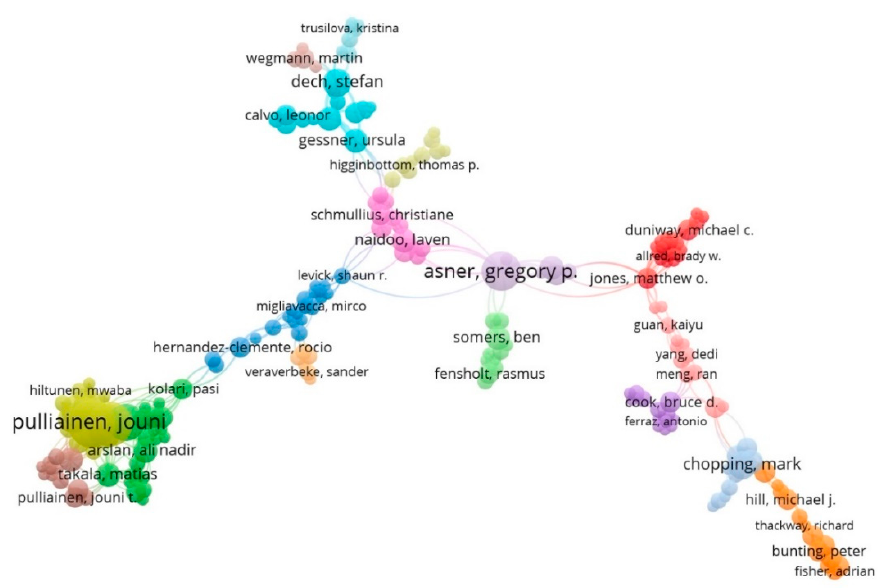
Figure 5. Network visualisation map (WoS database) of the co-authorship based on authors that have a minimum of one number of citations (fractional counting).